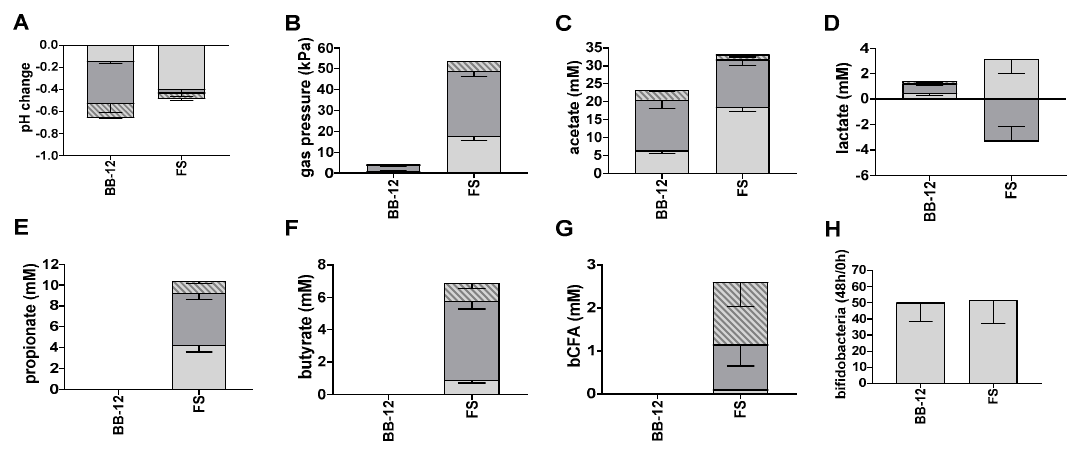
Figure 3. Metabolic activity of BB-12 in presence of sterile fecal suspension of six donors (‘BB-12 ′ ) and of the fecal microbiota of the six same donors as such (‘FS’) upon dosing starch as carbon source. Bars represents the average changes (±SEM) in pH ( A ), gas production ( B ), acetate (( C ); mM), lactate (( D ); mM), propionate (( E ); mM), butyrate (( F ); mM) and bCFA (( G ); mM) levels between 0 and 6 h (light grey), 6 h and 24 h (dark grey) and 24 h and 48 h (stripes) as well as changes in Bifidobacterium levels (( H ); expressed as the ratio of their absolute abundance as measured via qPCR at the end versus the beginning of the incubation (48 h/0 h)) ( n = 6). BB-12 = Bifidobacterium animalis subsp. lactis; SEM = standard error of means.